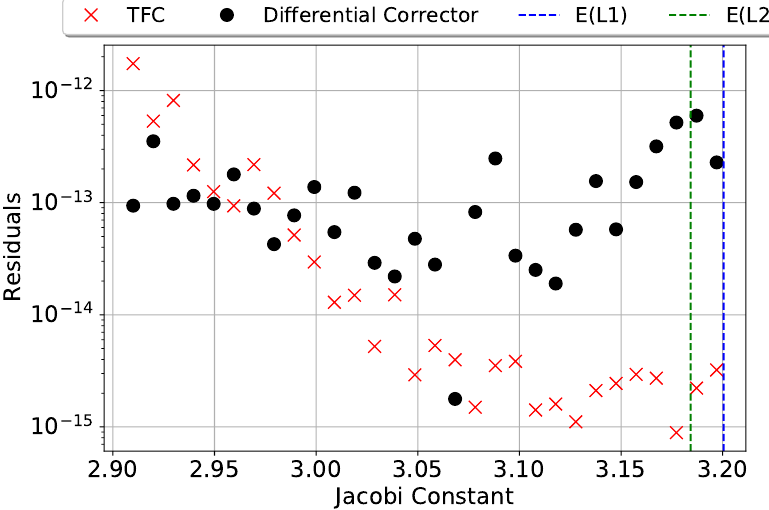
Figure 4. Maximum residuals of the loss vector for the TFC method solving for the trajectories plotted in Figure 2a compared to that of the differential corrector. The lines of E(L1) and E(L2) represent the energy of the L1 and L2 Lagrange points, respectively. The TFC approach has a slight accuracy advantage (an order of magnitude) as compared to the differential corrector method at higher Jacobi